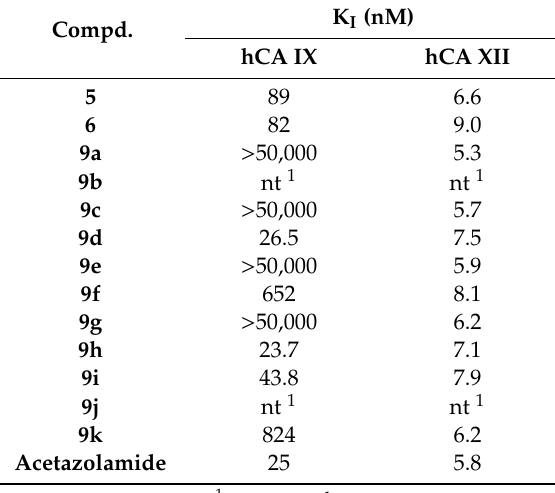
Table 7. CA IX and XII inhibition data for compounds 5 , 6 and sulfonamides 9a – j .